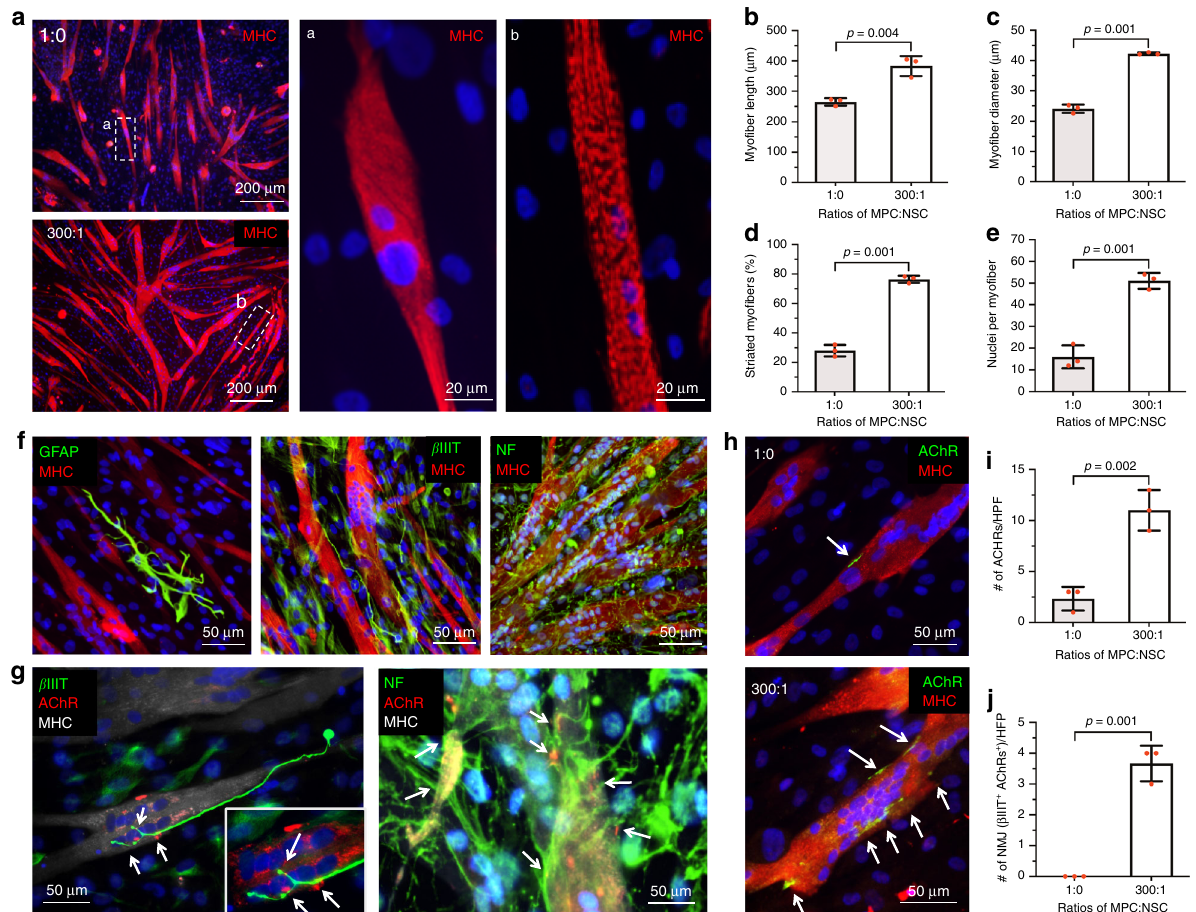
Fig. 1 Two-dimensional (2D) co-culture of human muscle progenitor cells (hMPCs) and human neural stem cells (hNSCs) with different ratios. a Immuno fl uorescence for myosin heavy chain (MHC) (red)/DAPI (blue) of hMPCs culture (1:0) and co-culture (hMPCs:hNSCs = 300:1) at 5 days of differentiation; Striated myo fi ber structure of a hMPCs (1:0) and b co-culture of hMPCs and hNSCs (300:1). b – e Quanti fi cation of myo fi ber formation; b myo fi ber length ( µ m) ( n = 3 per group), c myo fi ber diameter ( µ m) ( n = 3 per group), d striated myo fi bers (%) ( n = 3 per group), and e nuclei per myo fi ber ( n = 3 per group). Co-culture group showed increased density, length, diameter, and striation of myo fi bers, as well as a number of nuclei per myo fi ber compared with the hMPCs only group. f Glial and neuronal differentiation of hNSCs in 2D co-culture. Immuno fl uorescence for glial fi brillary acidic protein (GFAP, glial cells, green)/MHC (red), beta-III tubulin ( β IIIT, neurons, green)/MHC (red), and neuro fi laments (NF, green)/MHC (red). g , h Acetylcholine receptor (AChR) clustering and neuromuscular junction (NMJ) formation (white arrows). g Immuno fl uorescence for β IIIT (green)/AChR (red)/MHC (gray) and NF(green)/AChR (red)/MHC (gray) in 2D co-culture. h Immuno fl uorescence for AChRs (green)/MHC (red) in hMPCs cultures and 2D co-culture. i The number of AChRs per fi eld ( n = 3 per group) and j co-localizations ( β IIIT + AChRs per fi elds) ( n = 3 per group). All data are represented as mean ± SD. The p -values by two-sided Student t -test are